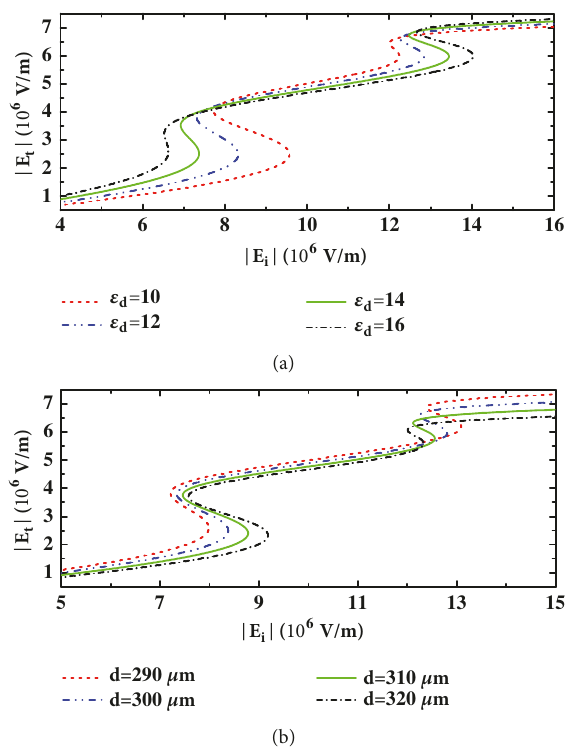
Figure 4: Schematic diagram of the influence of the dielectric constant (a) and the thickness (b) of the dielectric plate on the tristable phenomenon. The other parameters are the same as